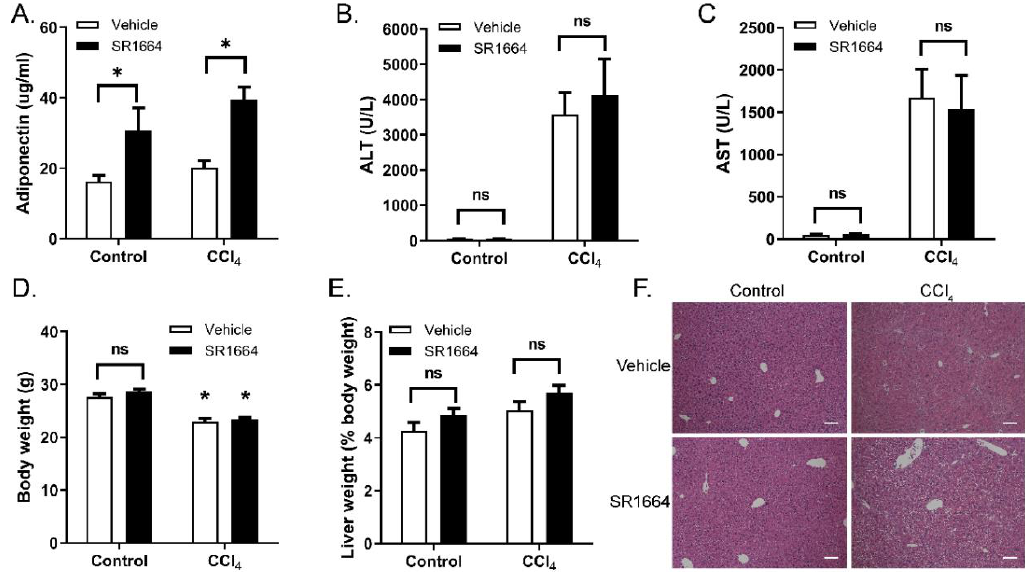
Figure 1. Serum determinations and histology from control or fibrotic mice treated with SR1664 or vehicle. ( A ) Serum adiponectin levels; ( B , C ) Serum ALT and AST levels; ( D ) Total body weight; ( E ) Liver weight expressed as percent total body weight; ( F ) Hematoxylin and eosin staining of liver sections. Bar = 200 µm; mean ± S.E.M; n = 6; * p < 0.05 by ANOVA; ns: not significant.